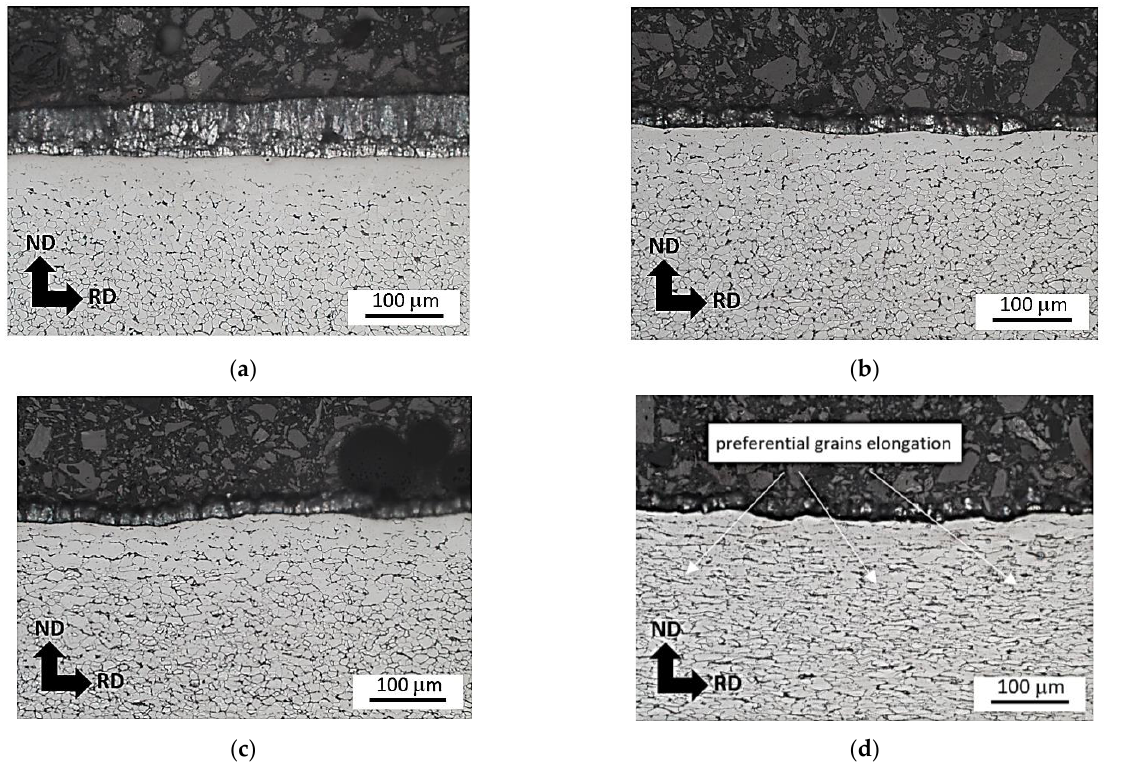
Figure 11. Metallographic images of the matrix and delamination of the Zn layer during tensile test as a function of plastic strain for strain rate 32.0 × 10 −3 s −1 . ( a ) ε = 5.0%, ( b ) ε = 11.8%, ( c ) ε = 18.7%, ( d ) ε = 32.5%.